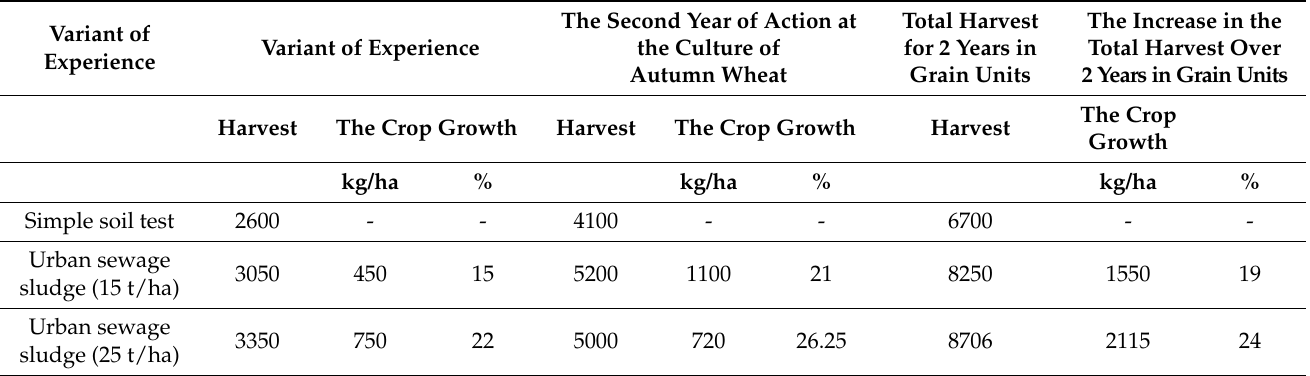
Table 3. The influence of the sludge from the wastewater treatment process in the Municipality of Alexandria, Teleorman on the harvest of soybeans and autumn wheat kg/ha.